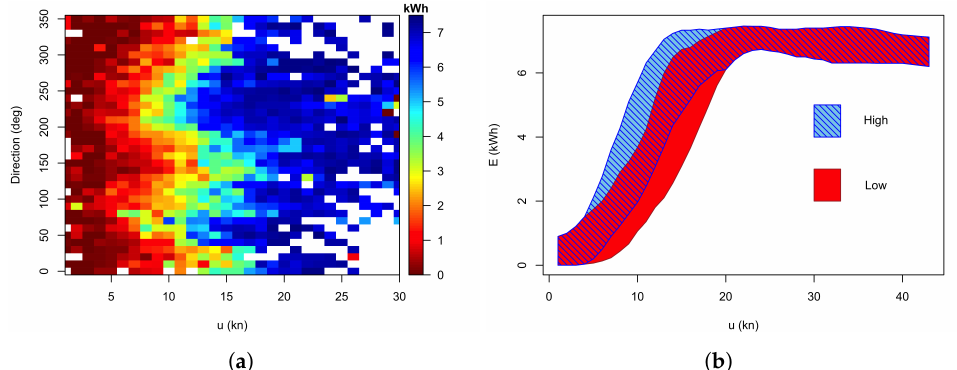
Figure 4. ( a ) Heat map of the median electricity production by wind speed and direction. ( b ) Refinement of performance expectations for distinct wind directions, showing the bands of S d = 1 for the two directional